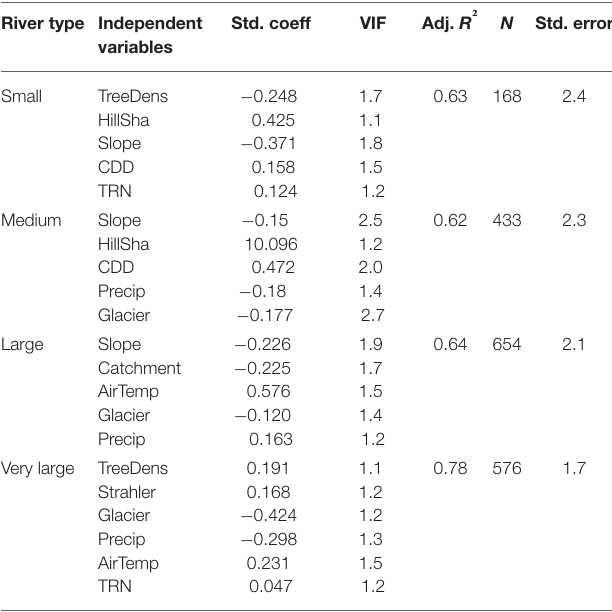
TABLE 4 | Included variables in the linear regression models of the four rivers types (small to large rivers), including standardized coefficients (Std. Coeff), variance inflation factor (VIF), adjusted R ² (Adj. R ² ), the count ( N ), and the standard error (Std.